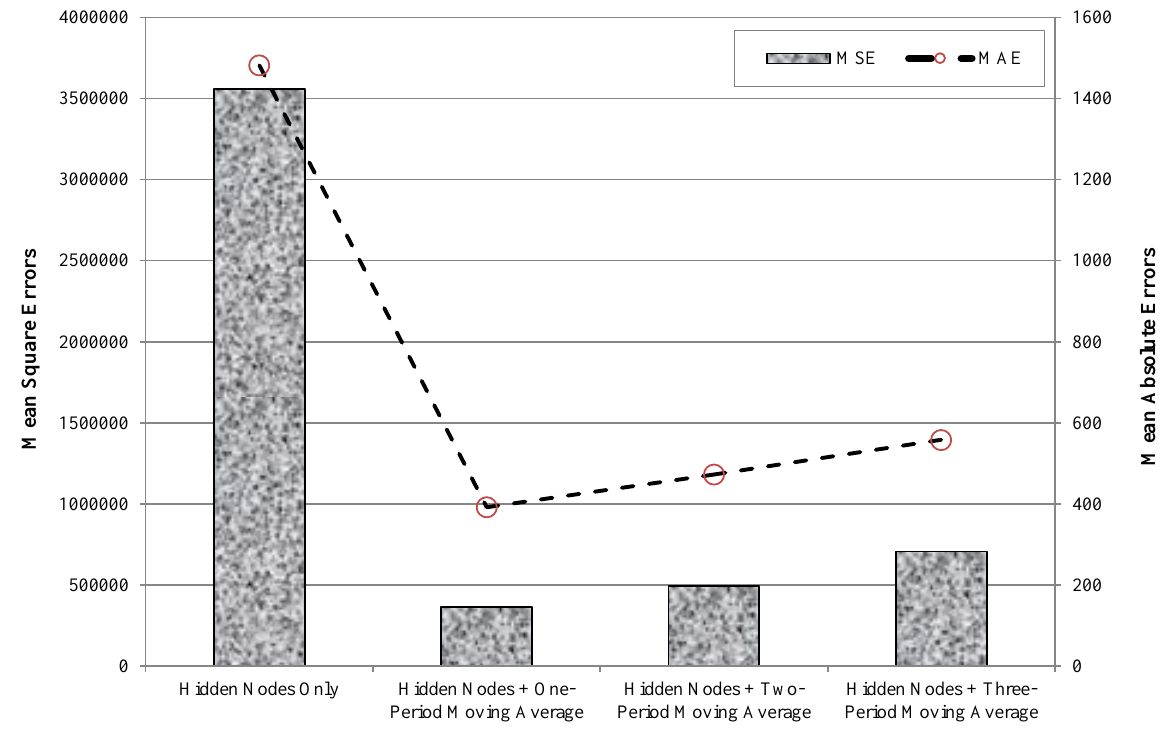
Figure 3. The performance criteria for combined neural network models with moving